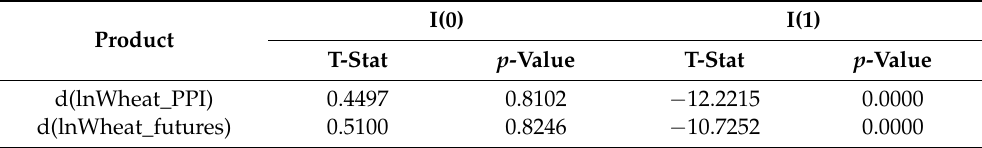
Table 2. Stationarity tests of logarithmic cash and futures prices of wheat in the USA.